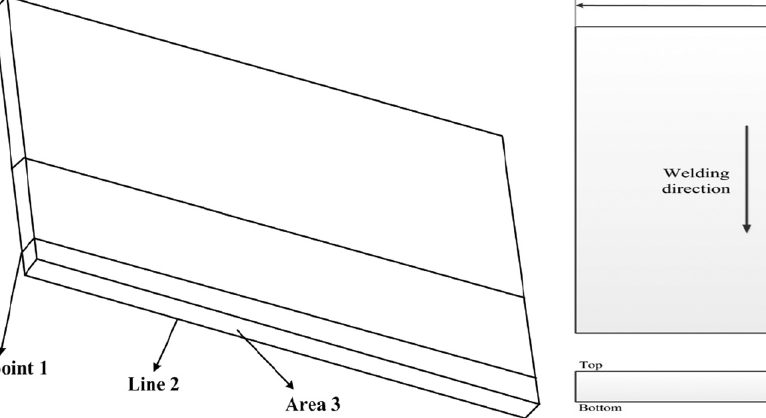
Figure 5: Schematic diagram of temperature measurement in the GTAW